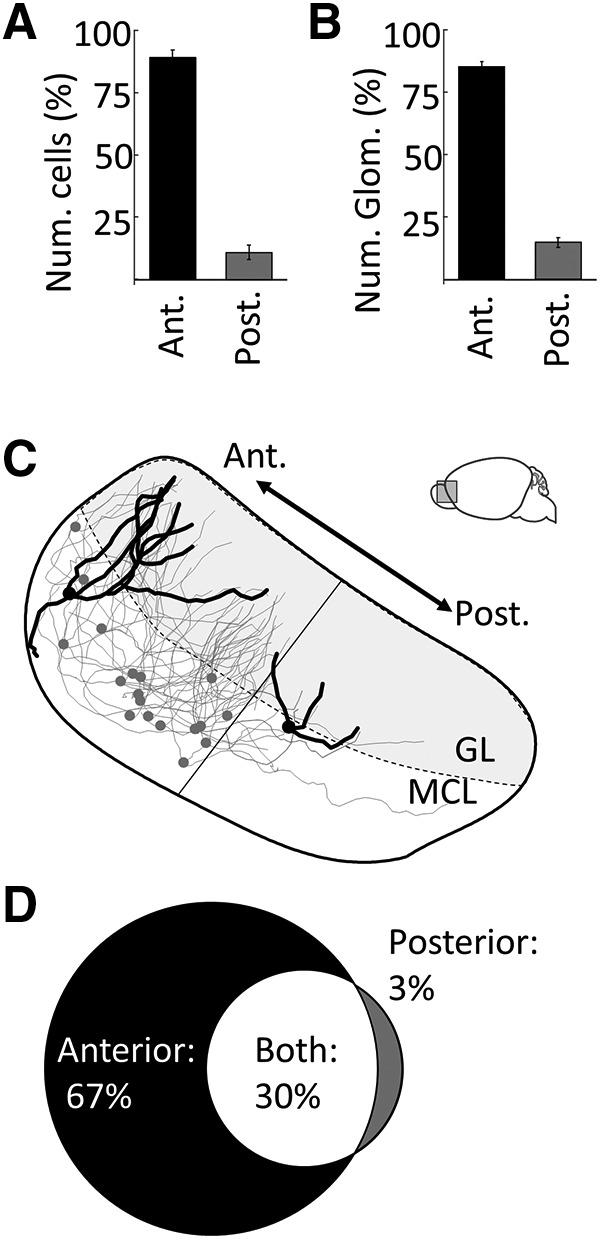
Quantitative analysis of AOB input to arom+ neurons in the MeA. A, Percentage of →arom+ neuron cell bodies in the anterior versus posterior AOB. B, Percentage of →arom+ glomeruli in the anterior versus posterior AOB. C, Neuroanatomical reconstruction of the all →arom+ in the MeA of a single female mouse. Two neurons are highlighted: the first receives input only from anterior glomeruli, while the second, with a markedly smaller dendritic arbor, receives input from only posterior glomeruli (linea alba, thin straight line). D, The fraction of →arom+ neurons that receive input from only the anterior AOB glomeruli (black), from only the posterior AOB glomeruli (gray), or from both the anterior and posterior AOB glomeruli (white). Error bars indicate SEM.